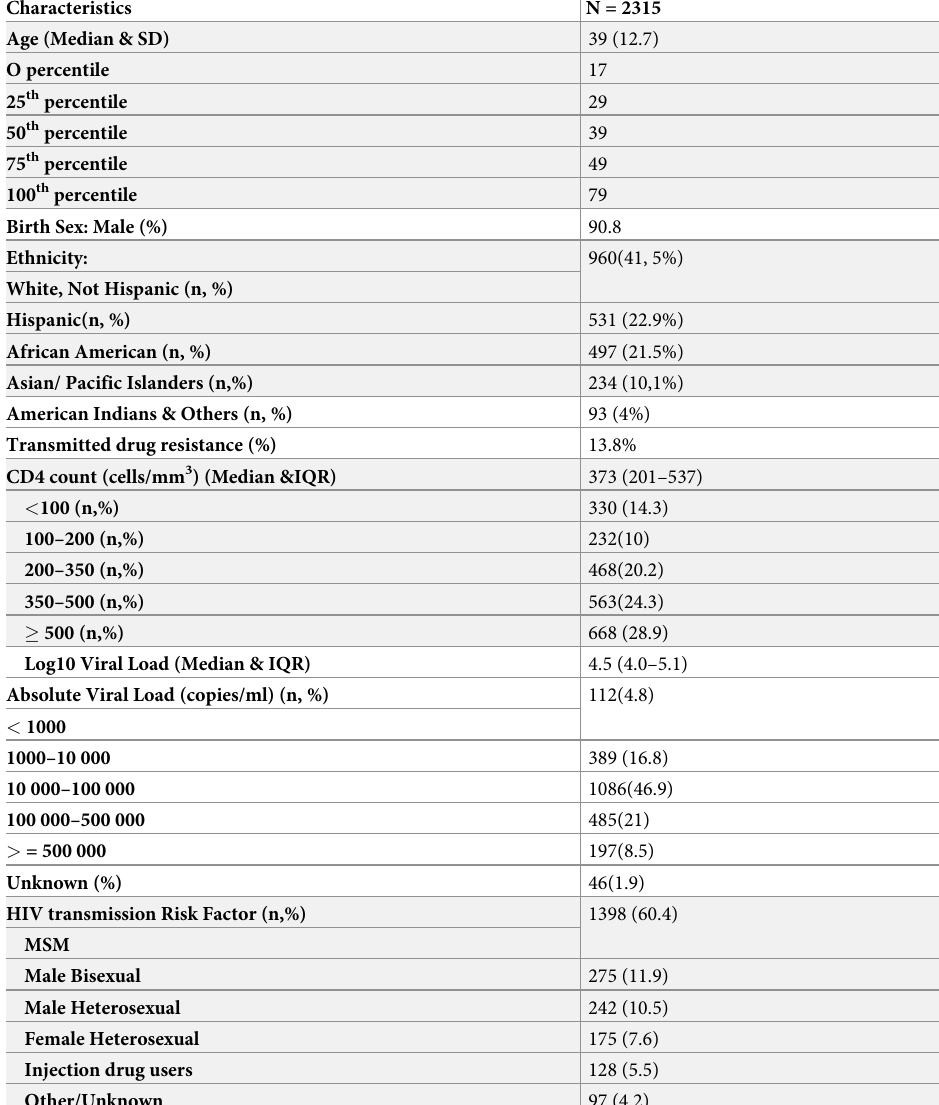
Table 1. Baseline characteristics of the cohort at start of antiretroviral therapy, median (IQR) or N (%).